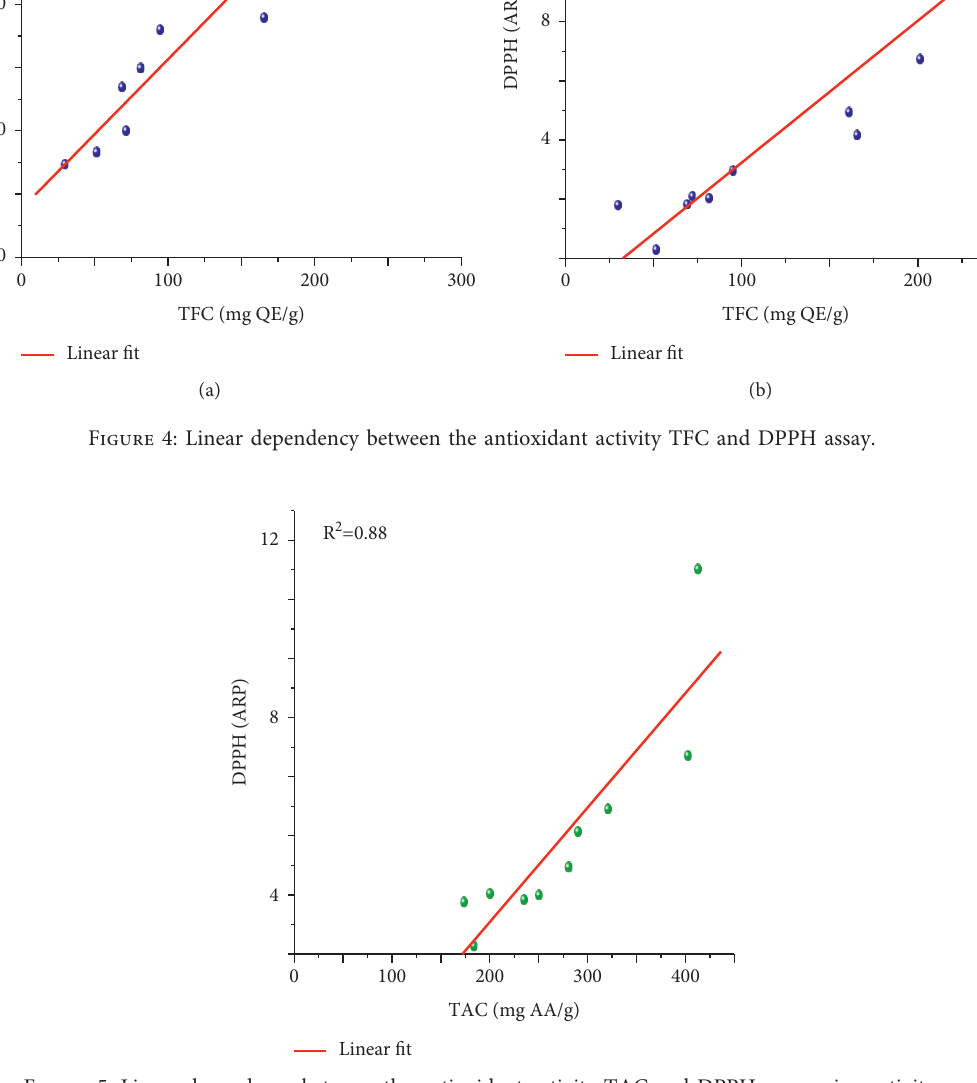
Figure 5: Linear dependency between the antioxidant activity TAC and DPPH scavenging activity.